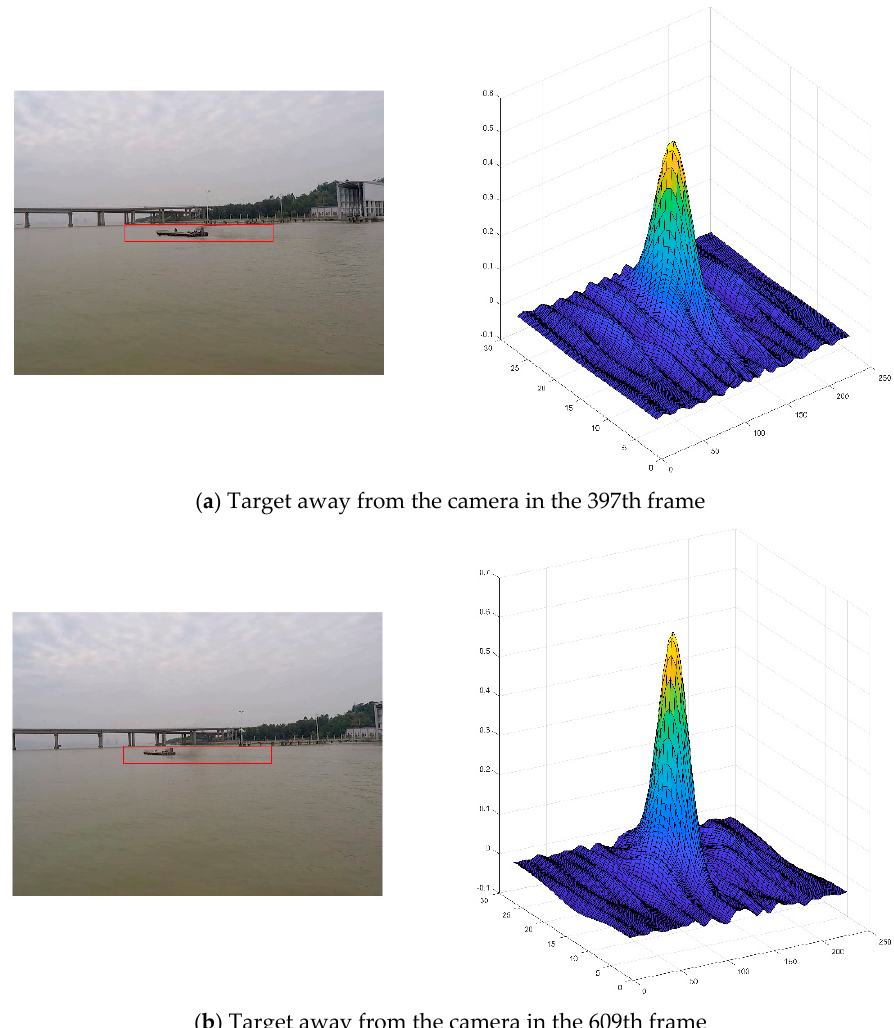
Figure 6. Target away from camera causing loss of target: ( a ) Target away from the camera in the 397-th frame; ( b ) Target away from the camera in the 609-th frame. The image on the left is the tracking result of the current frame while the graph on the right is the filtering response of the current frame.